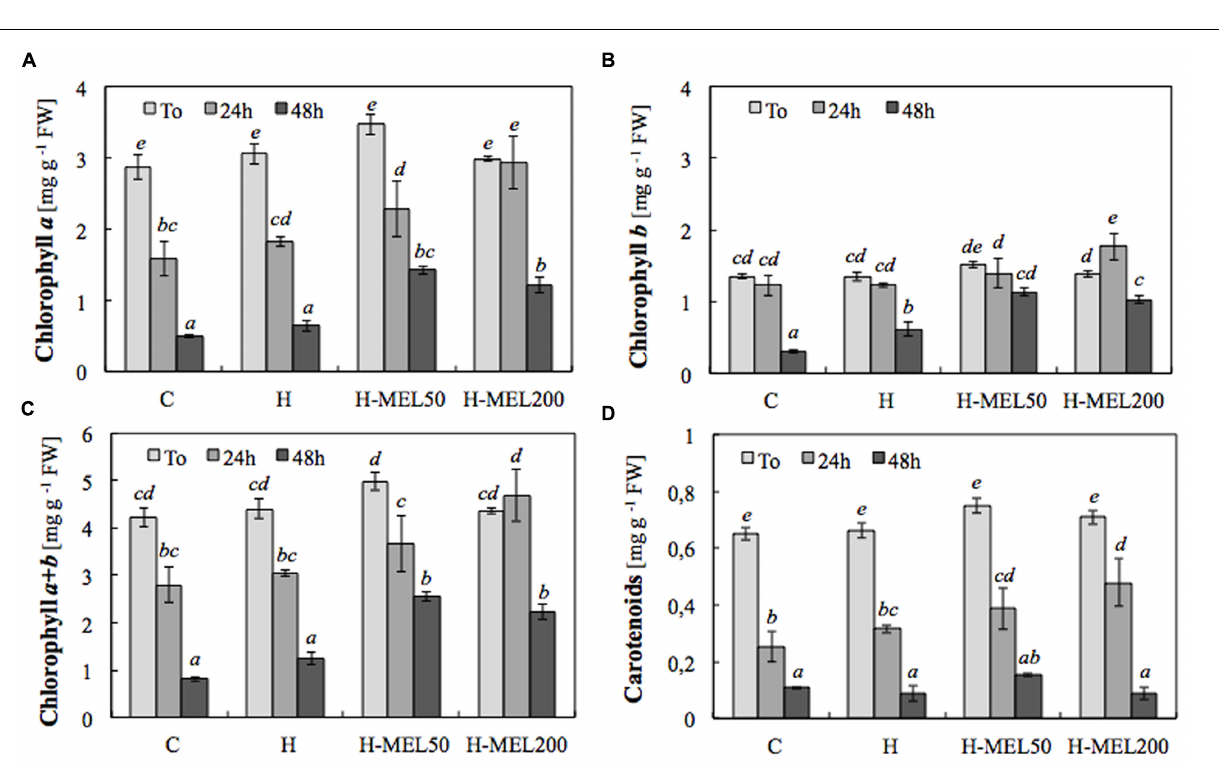
FIGURE 3 | Contents of chlorophyll a (A), b (B), a + b (C) and carotenoids (D) in leaf disks cut from 24-day-old pea plants grown from the control (C), hydroprimed (H), and hydroprimed with an aqueous solution of 50 µ M melatonin (H-MEL50) or 200 µ M melatonin (H-MEL200) seeds.